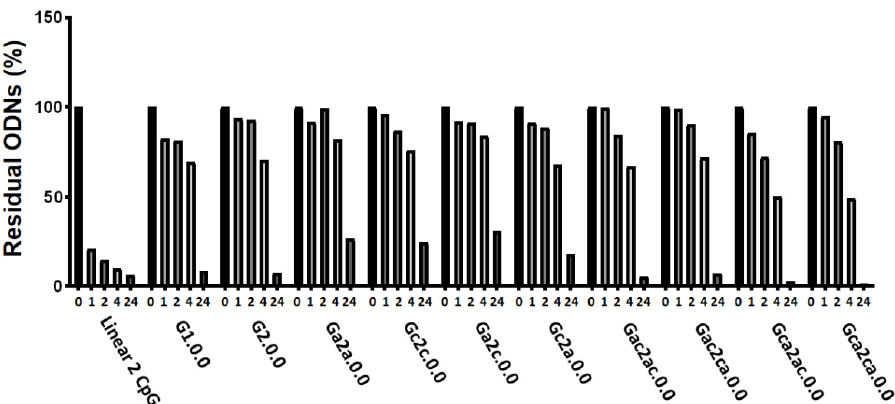
Figure 7. Degradation of G-quadruplex CpG ODNs in serum. Each ODN was incubated in 20% fetal bovine serum for 1, 2, 4, and 24 h at 37 ◦ C. Percentage of residual ODN was analyzed by polyacrylamide gel electrophoresis with SYBR Gold staining. Table 2. Melting temperature at the first cooling and second heating of antiparallel ODNs with CpG motif substitutions in the first functional loop, with or without additional connectors, obtained from CD-melting curves in D-PBS.